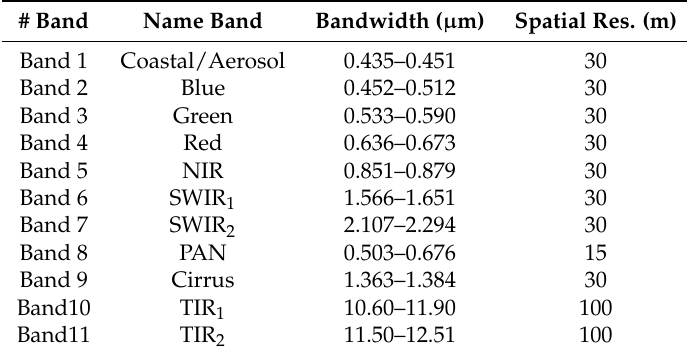
Figure 2. Thermal Infrared bands (TIR) of the study site, located in the region of Biobío (Chile) and registered on 16 February 2016. Table 1. Landsat-8 OLI and TIRs spatial and spectral